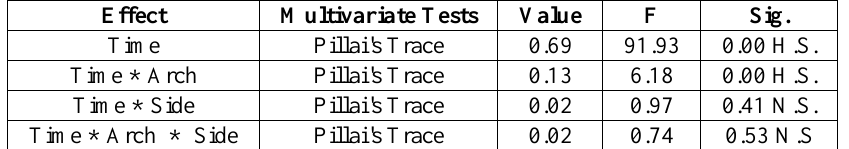
during six months of treatment to reach 25.39%. Additionally the data revealed that the most predominant cumulative white spot lesions scores were equal one (CS1) that reached 38.1% and CS2 that reached 17.97%.